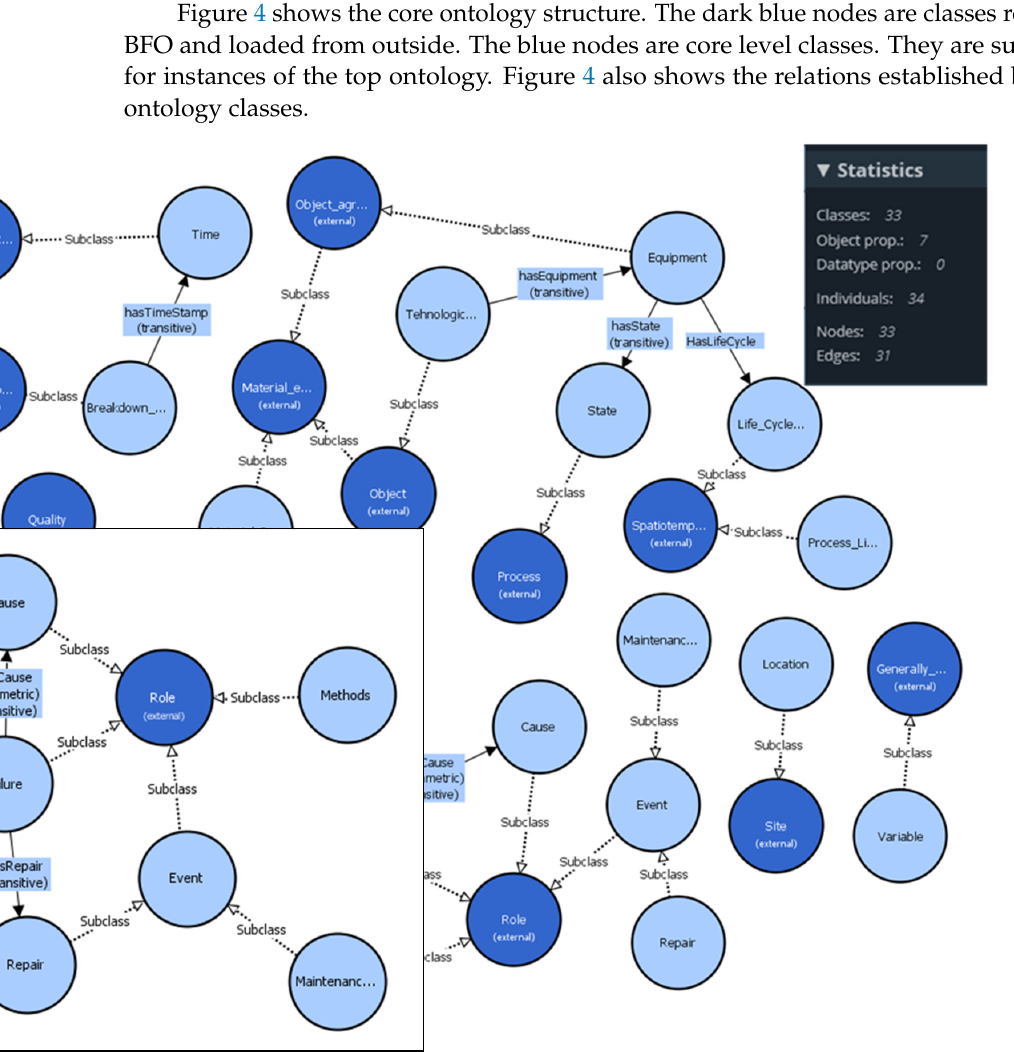
Figure 4. VOWL-graph core ontology.